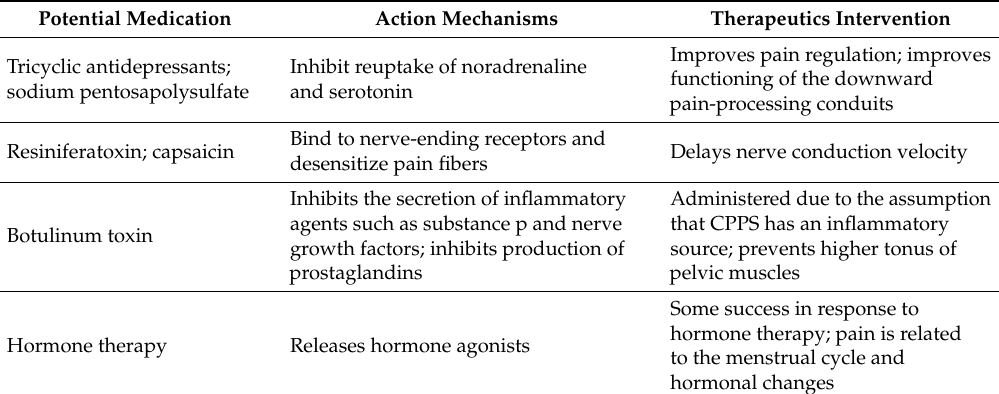
Table 1. Possible drug treatment interventions for